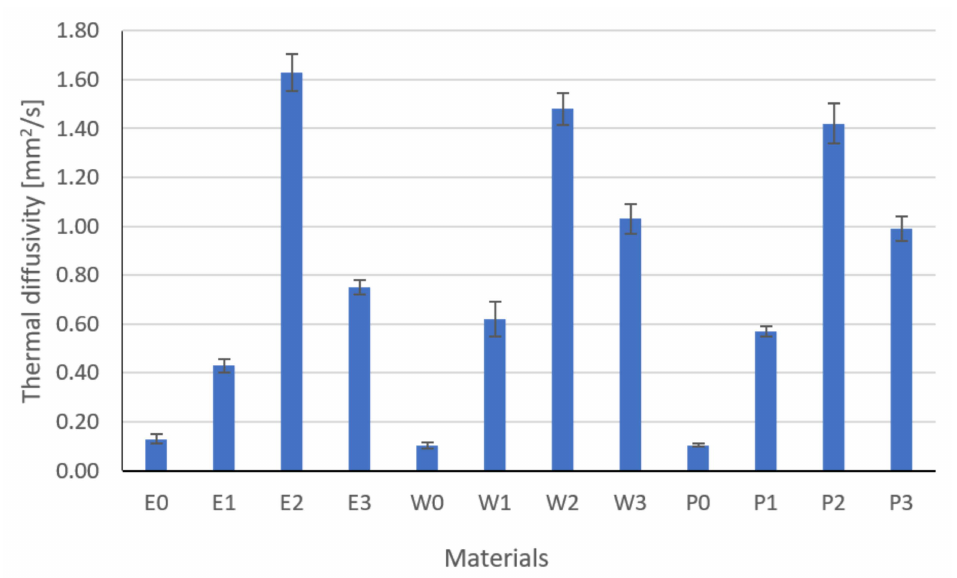
Figure 11. Results of thermal